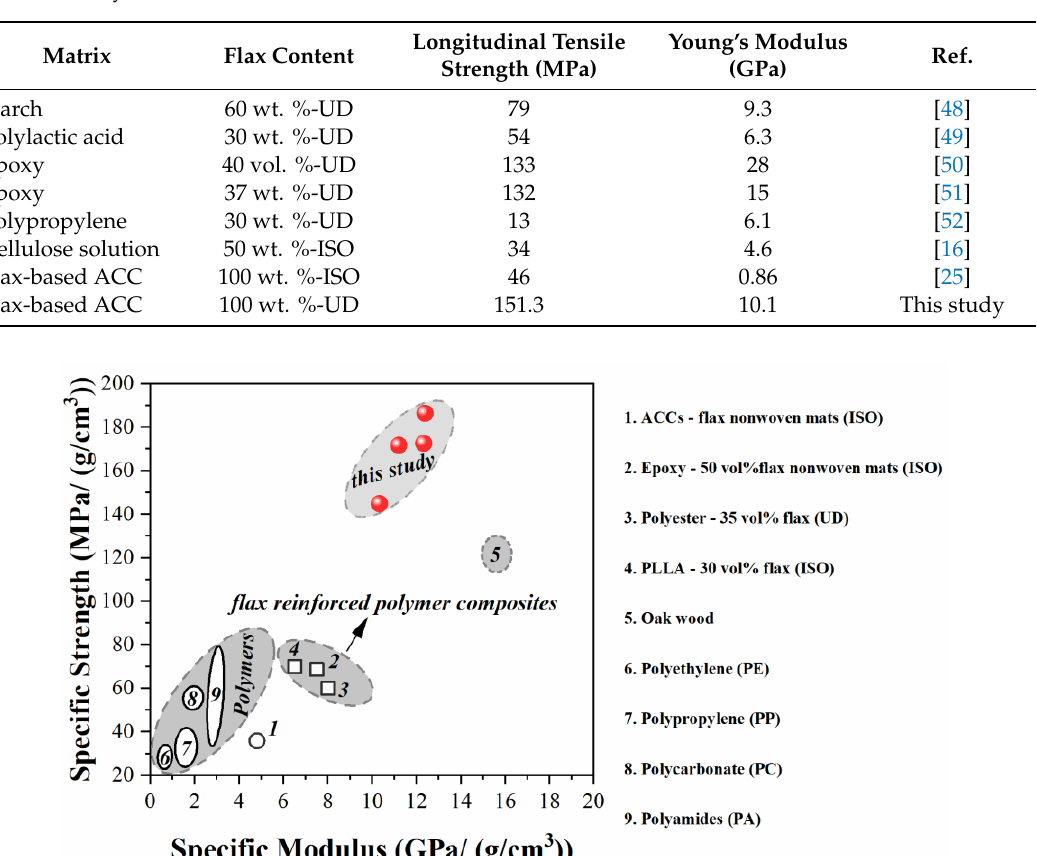
Figure 8. Comparison of the specific mechanical properties of unidirectional flax-based ACCs made in this work with those of other flax-based structures (1 [16]), flax-reinforced composites (2 [16], 3 [53] and 4 [53]), oak wood (5 [54]) and conventional polymers (6 [55], 7 [55], 8 [55] and 9 [55]). UD means unidirectional while ISO means isotropic.